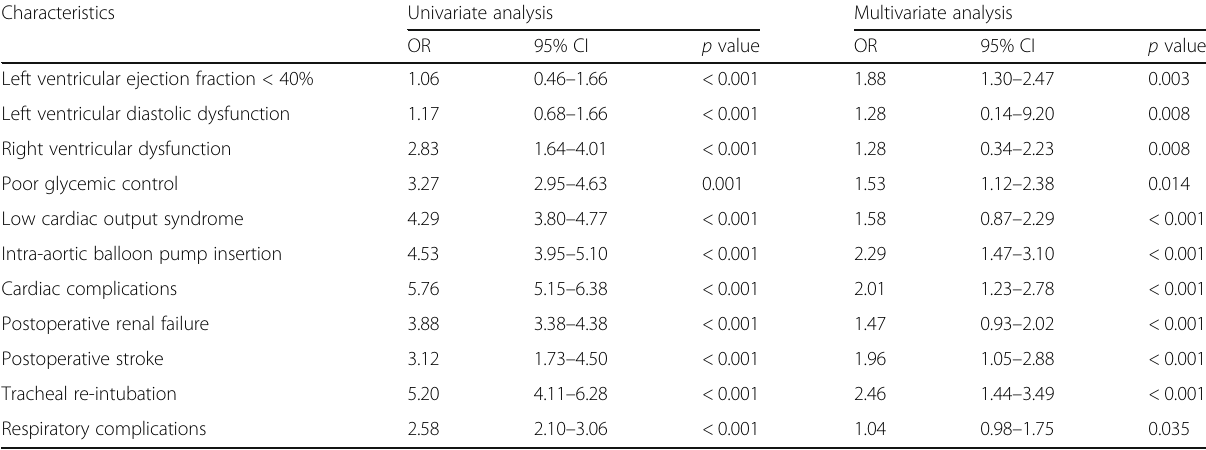
Table 2 Independent predictors of in-hospital mortality on binary logistic regression analysis (all patients) Characteristics